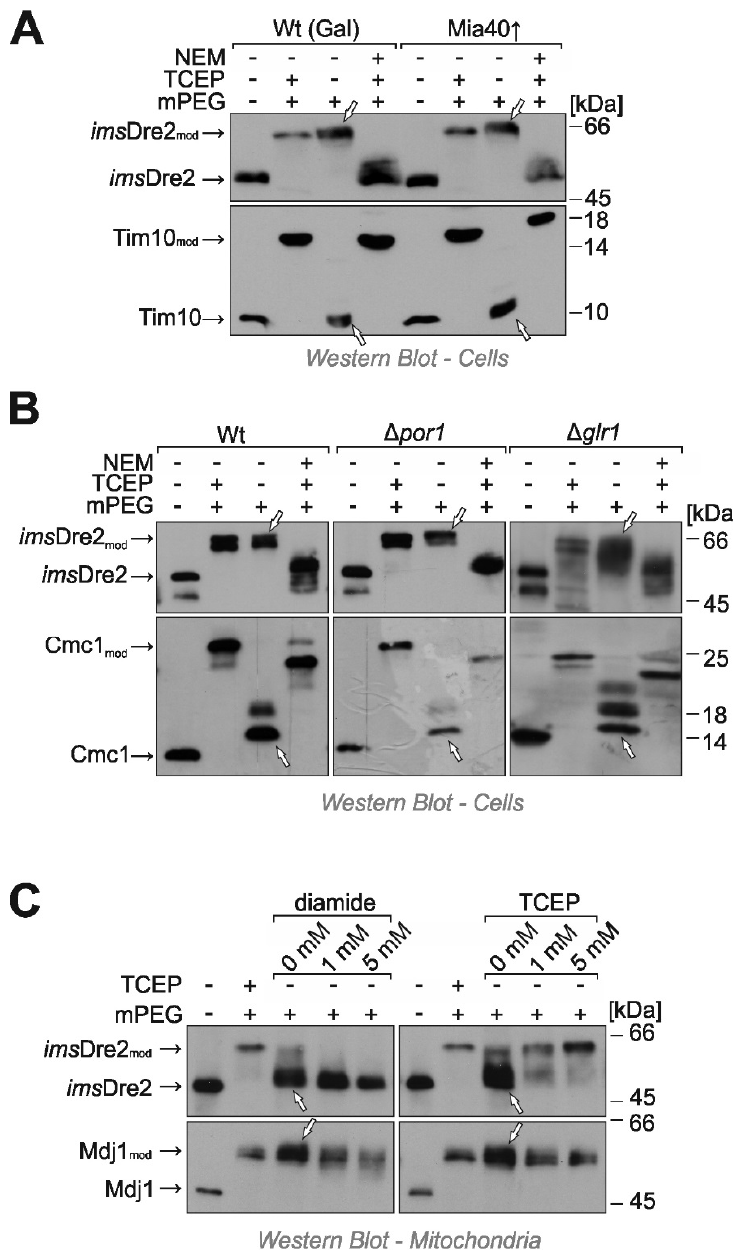
FIGURE 5: Despite its location in the IMS, ims Dre2 does not contain disulfides. (A, B) The redox state of disulfides in ims Dre2 and control proteins was analyzed in wild type, ∆ por1 and ∆ glr1 cells as de- scribed in Fig. 3. (C) Mitochondria were isolated from ims Dre2-expressing cells, incubated in the presence or absence of diamide or TCEP. Proteins were TCA-precipitated before their redox state was analyzed as described